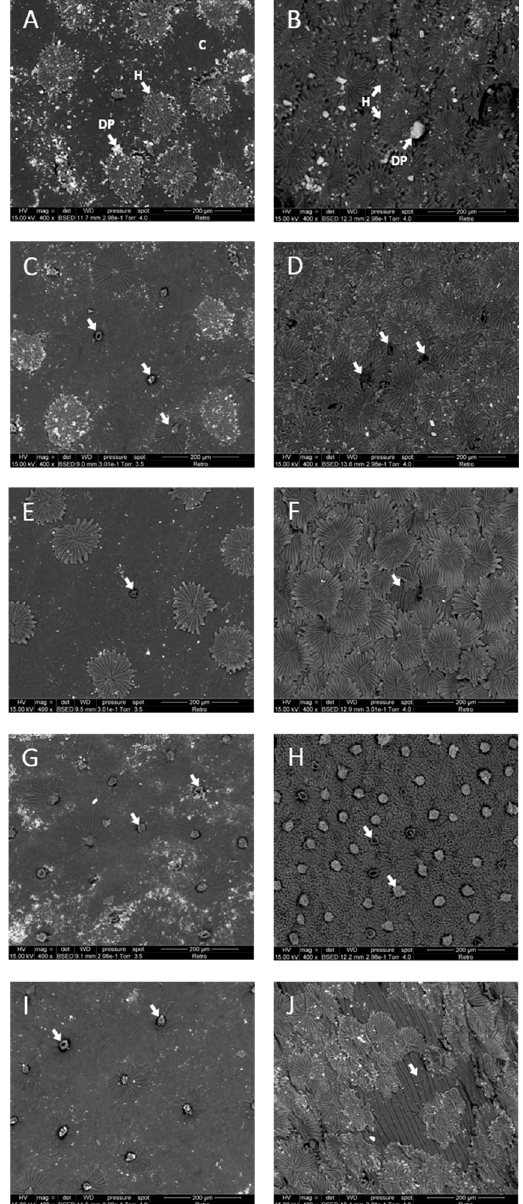
Figure 2. Comparison of leaf surface by Environmental Scanning Electron Microscopy (ESEM) for an untreated leaf, a control leaf (60 min stirring), and ultrasound treated leaves (5 min, 15 min, and 60 min). Legend (Figure 2): Cuticle (C), Hairs (H), and Dust Particles (DP). All observations were made at a magnification of 400 × the original picture’s scale and the scale is 200 µ m. Non labeled arrows designate observations of leaf structures discussed in the Results section. ( A , B ) Untreated olive leaf abaxial and adaxial side, respectively. ( C , D ) Control leaf, after 60 min of stirring at 20 °C, abaxial and adaxial side, respectively. ( E , F ) Leaf treated with ultrasound for 5 min at 20 °C, abaxial and adaxial side, respectively. ( G , H ) Leaf treated with ultrasound for 15 min at 20 °C, abaxial and adaxial side, respectively. ( I , J ) Leaf treated with ultrasound for 60 min at 20 °C, abaxial and adaxial side, respectively.